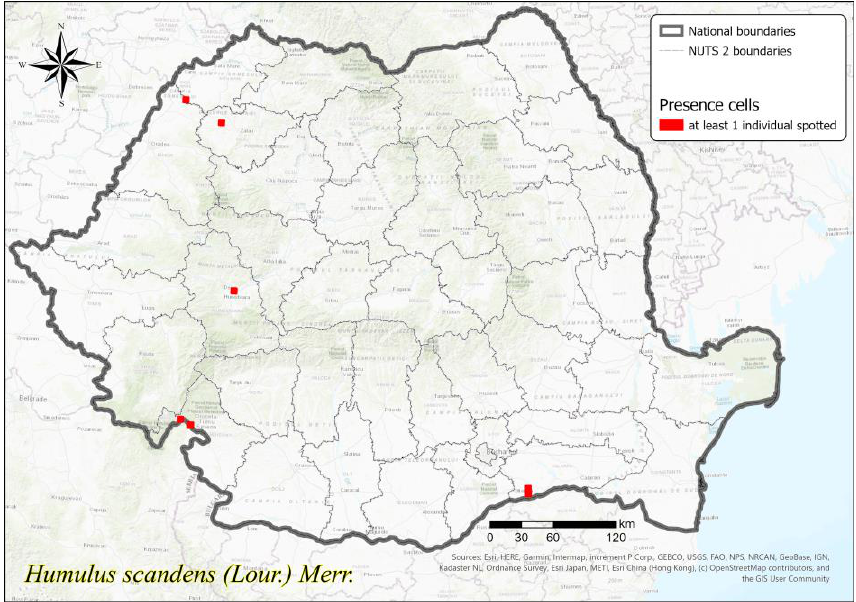
Fig. 6. Humulus scandens was reported from eight